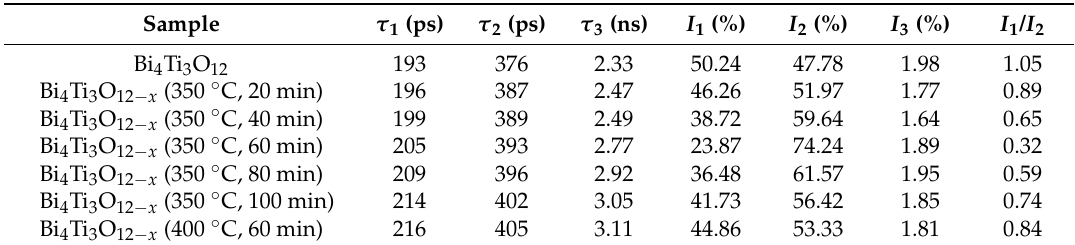
Positron lifetime and relative intensities of the pristine Bi 4 Ti 3 O 12 and various Bi 4 Ti 3 O 12 − x samples.